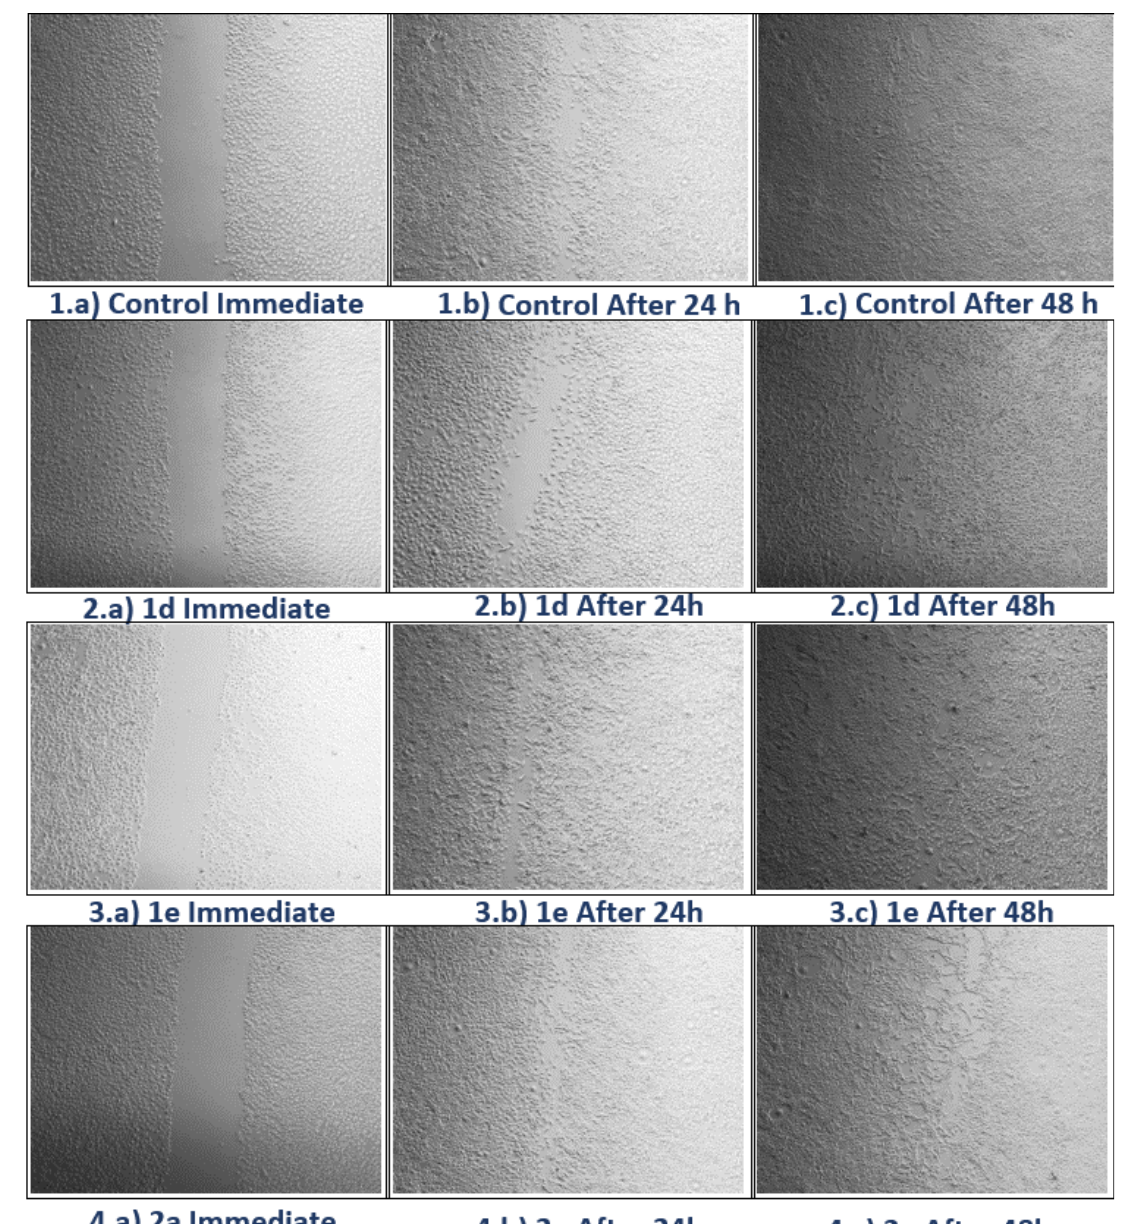
Figure 5. Analysis of cell migration by scratch assay for molecules 1d , 1e , and 2a on MDA-MB-231 cell line. Images were taken at 0 h, and 24 h, 48 h after incubation. Concentrations were 40 µM for 1d , 120 µM for 1e , and 30 µM for 2a. Control groups were treated with an equal amount of DMSO solvent.